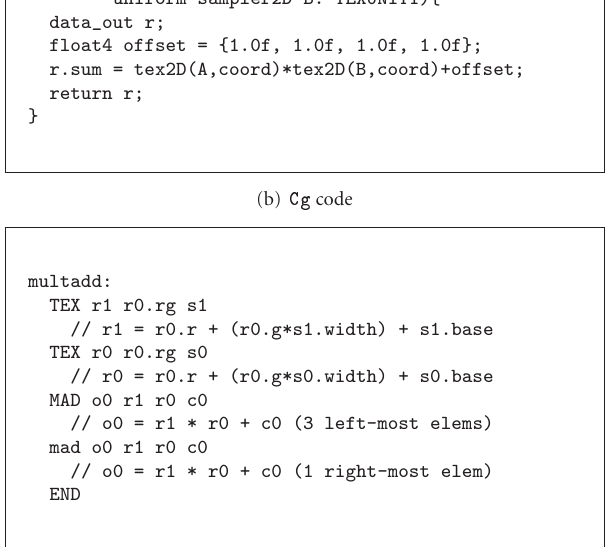
Figure 2: An example shader program for elementwise matrix multiplication plus an o ff set, described in (a)